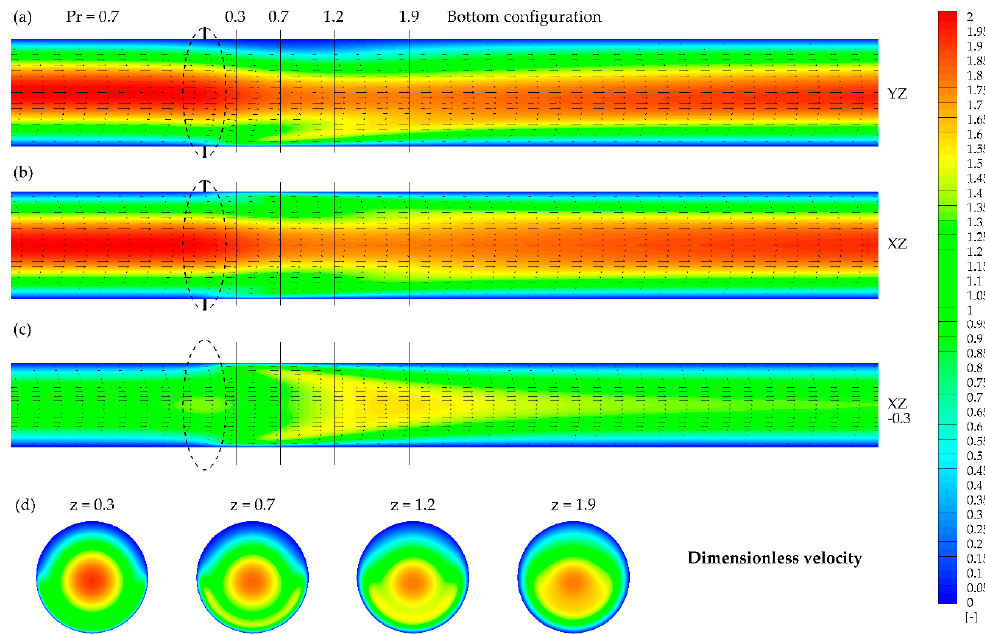
Figure 5. Dimensionless velocity contours and vectors obtained for Pr = 0.7 and bottom configuration in the presence of the magnetic field at: ( a ) YZ plane, ( b ) XZ plane, ( c ) XZ plane ( y = − 0.3), ( d ) XY planes at given z .